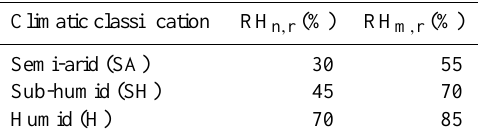
Table 1. Typical values of daily minimum relative humidity (RH n , r ) and its mean value (RH m , r ) for three types of climate (from FAO- 56, Table 16).